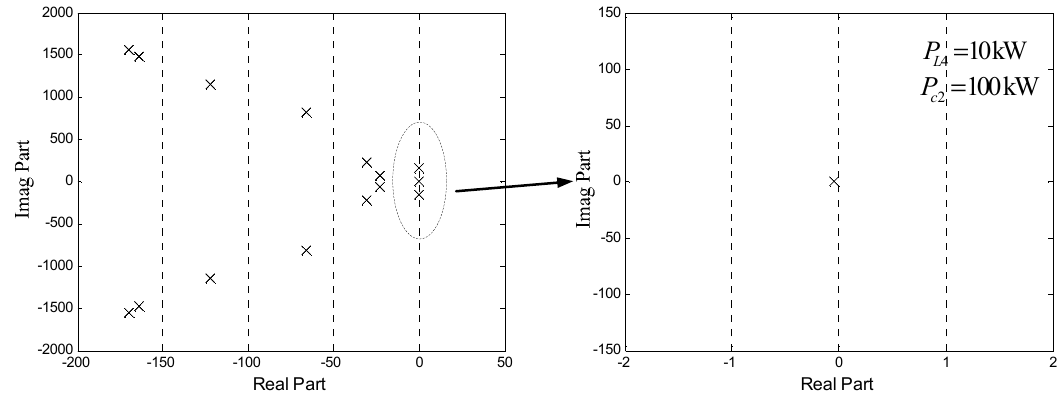
Figure 14. The dominant poles of